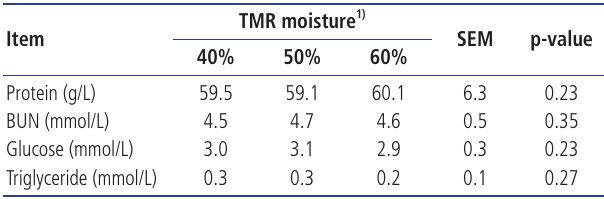
Table 5. Effects of adding water to TMR on serum biochemicals in ewes during hot and humid conditions